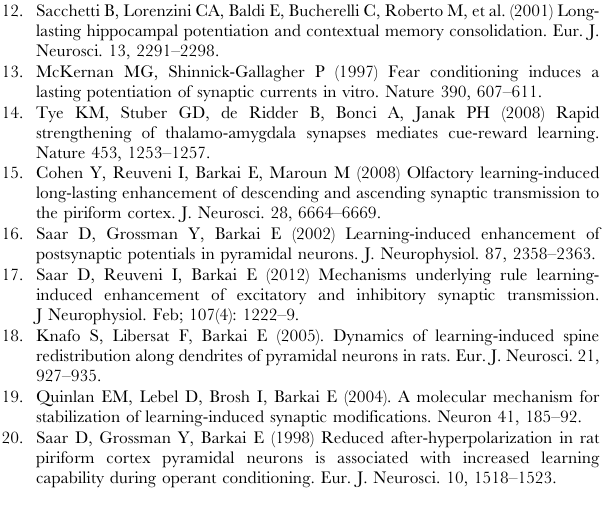
Table S1 When the difference between groups is moderate, a good correlation between the curve describing the averaged differences between groups and PC1 is attained only if big majority of the events were multiplied by the same factor, or if the multiplication factors had similar values. The distribution curves of the pseudo group were modified with different multiplicative transformations and then normalized. PCA analysis was calculated on a pool of distribution curves containing the pseudo and the transformed data. For each transformation, the correlation coefficient ( r ) between PC1 and the curve that resulted from subtracting the pseudo mean curve from the transformed mean curve was calculated. In addition the significance value between the weights of the two groups was calculated both for PC1 and PC2 ( PC1, PC2 ). Only 50% of the mepsc’s population